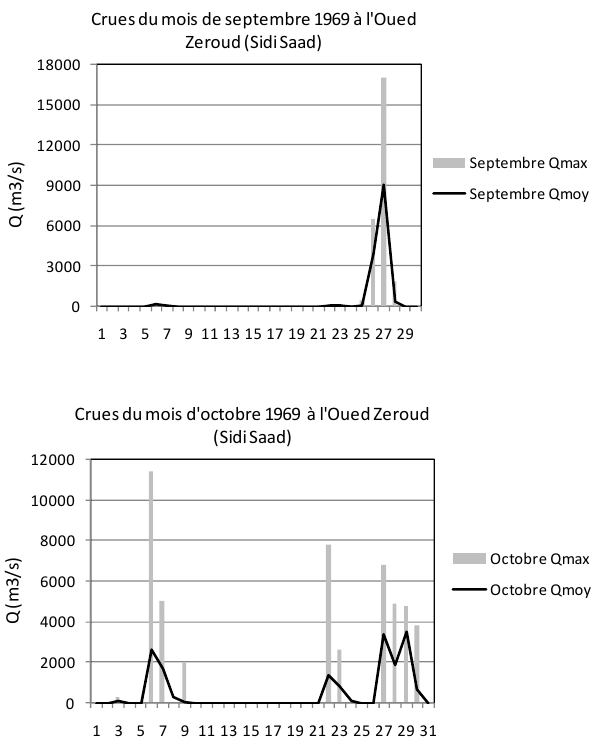
Figure 2. Crues de l’Oued Zeroud à la station de Sidi Saad en Sep- tembre et Octobre 1969 – Débits maximaux et moyens journaliers.